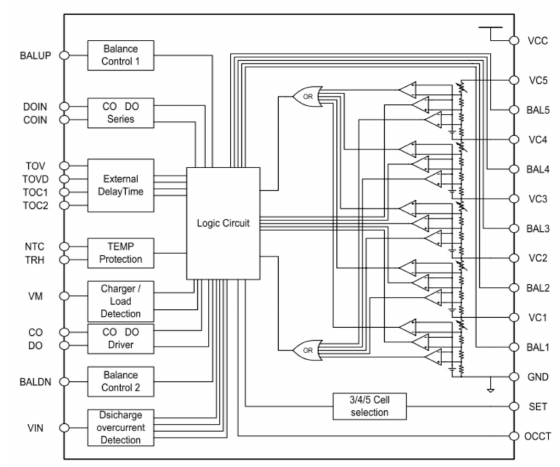
Figure 5. Block diagram of BM3451.